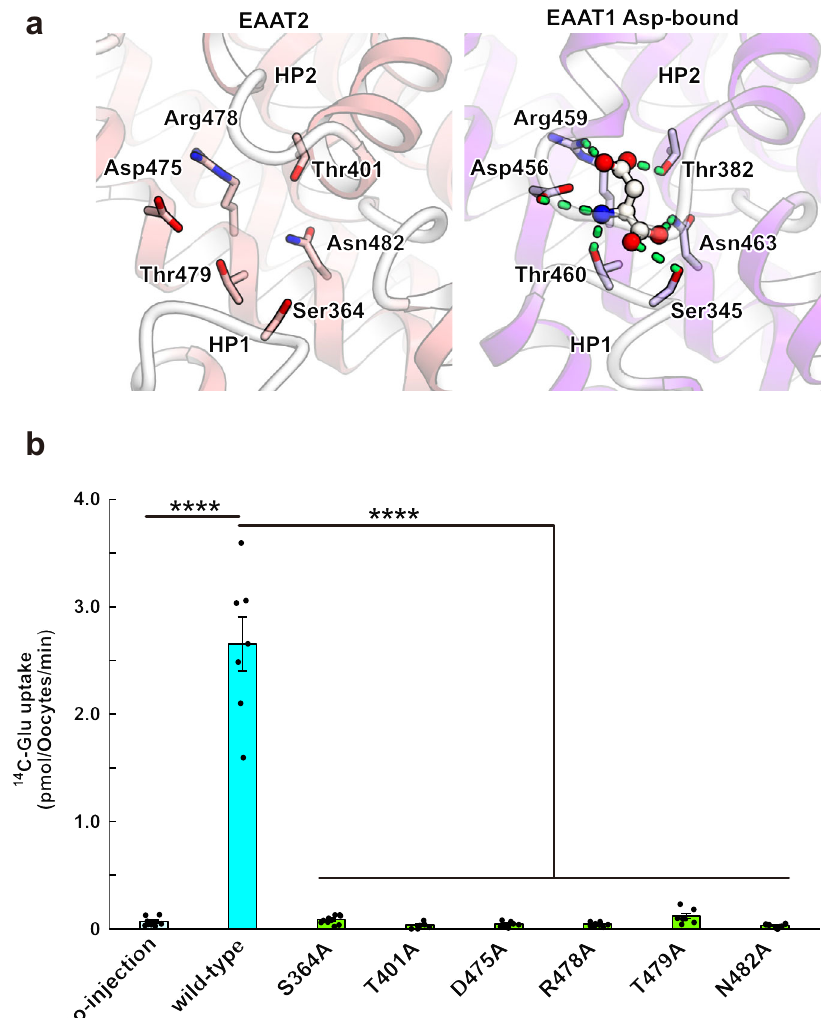
Fig. 3 | Glutamate-binding site. a Comparison of the substrate-binding site in HsEAAT2 with the structure of the aspartate bound-state of EAAT1 (PDB ID 5LLU). GreendotsindicateinteractionsbetweenaspartateandEAAT1. b Glutamate-uptake assay for point mutants, using Xenopus oocyte. Values are mean±s.e.m. n = 6 – 10 technicalreplicates( n =9,7,10,6,9,8,7,and7foron-injection,WT,S364A,T401A,